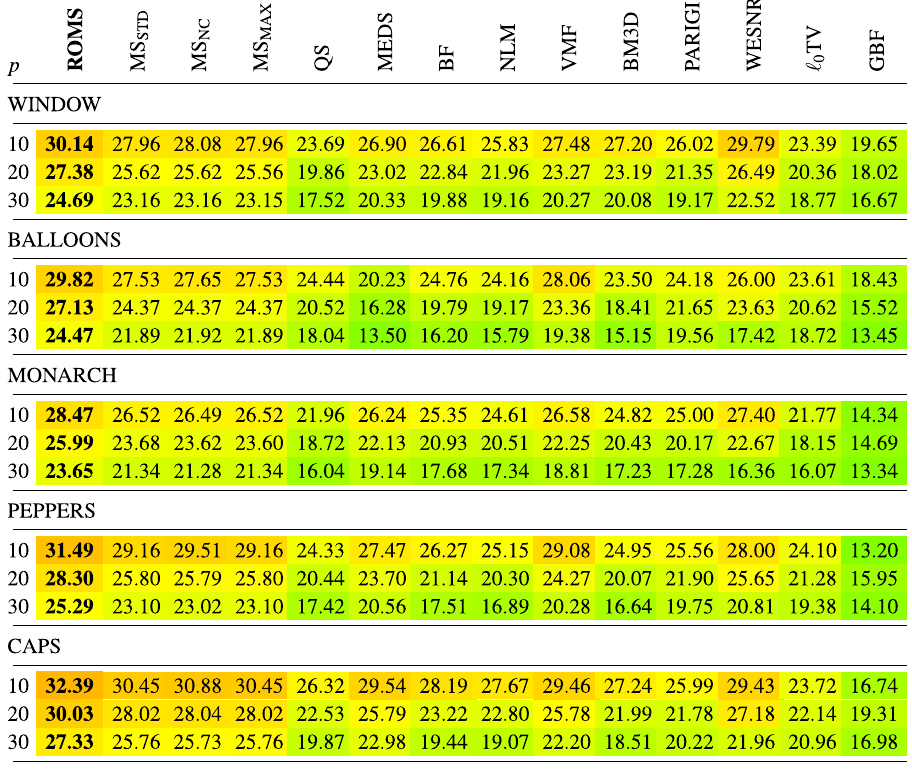
Table 2. Comparison of the IRI quality measure of the restored color test images contaminated with mixed noise using the proposed ROMS filter and state-of-the art filtering